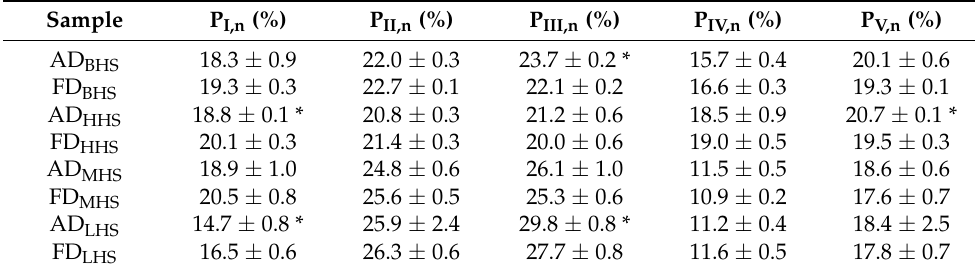
Table 3. Percentages of fluorescence region integration (FRI) among HHS, MHS, and LHS of the AD and FD